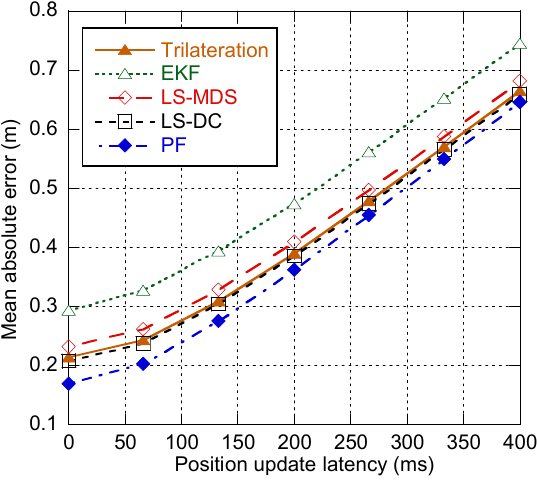
Figure 8. Positioning error depending on position update